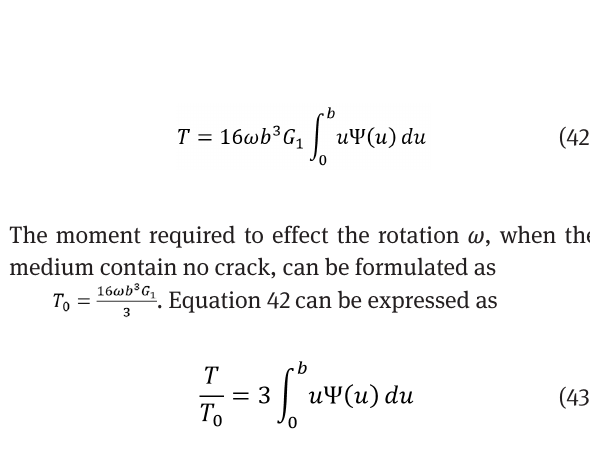
Figure 5: Tangential displacement u θ1 versus ρ for various ξ,